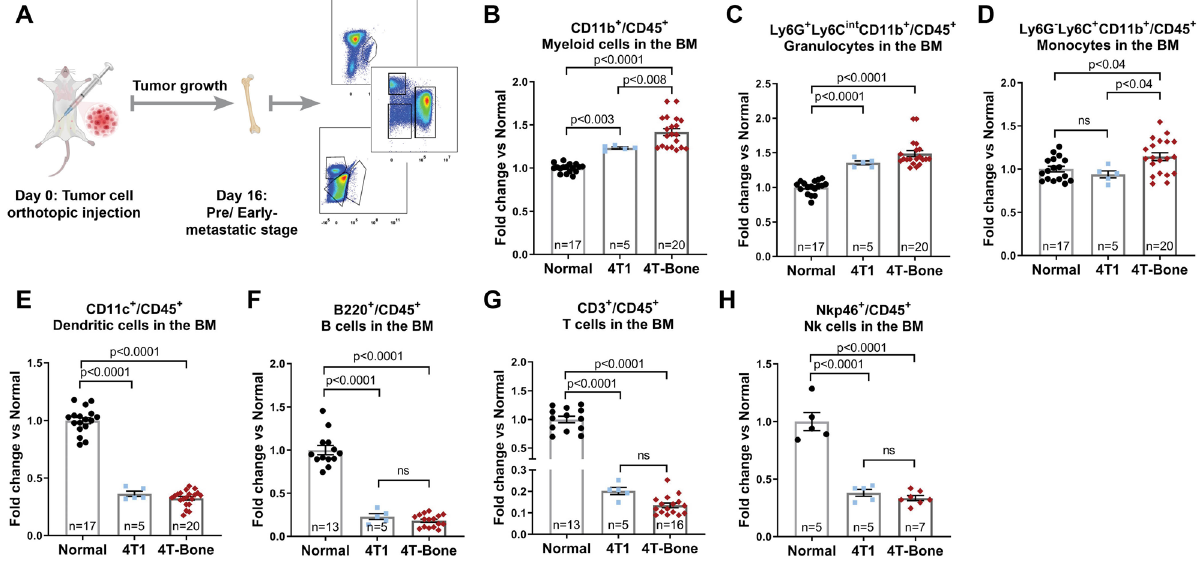
Figure 4. Immunosuppression in the BM precedes bone metastasis. ( A ) Scheme of the experimental design of early/pre-metastatic stage (day 16) analysis. ( B ) Quantification of the CD45 + CD11b + CD11c − total myeloid cell population. ( C ) Quantification of CD45 + CD11c − CD11b + Ly6G + Ly6C int granulocytes. ( D ) Quantification of CD45 + CD11c − CD11b + Ly6G − Ly6C + monocytes. ( E ) Quantification of CD45 + CD11b − CD11c + dendritic cells. ( F ) Quantification of CD45 + CD3 − B220 + B cells. ( G ) Quantification of CD45 + B220 − CD3 + T cells. ( H ) Quantification of CD45 + B220 − CD3 − Nkp46 + NK cells. Number of mice per each group is specified in graphs. Data are presented as % of CD45, normalized to the average of normal group. Error bars represent SEM. p < 0.05; Kruskal–Wallis multiple comparison